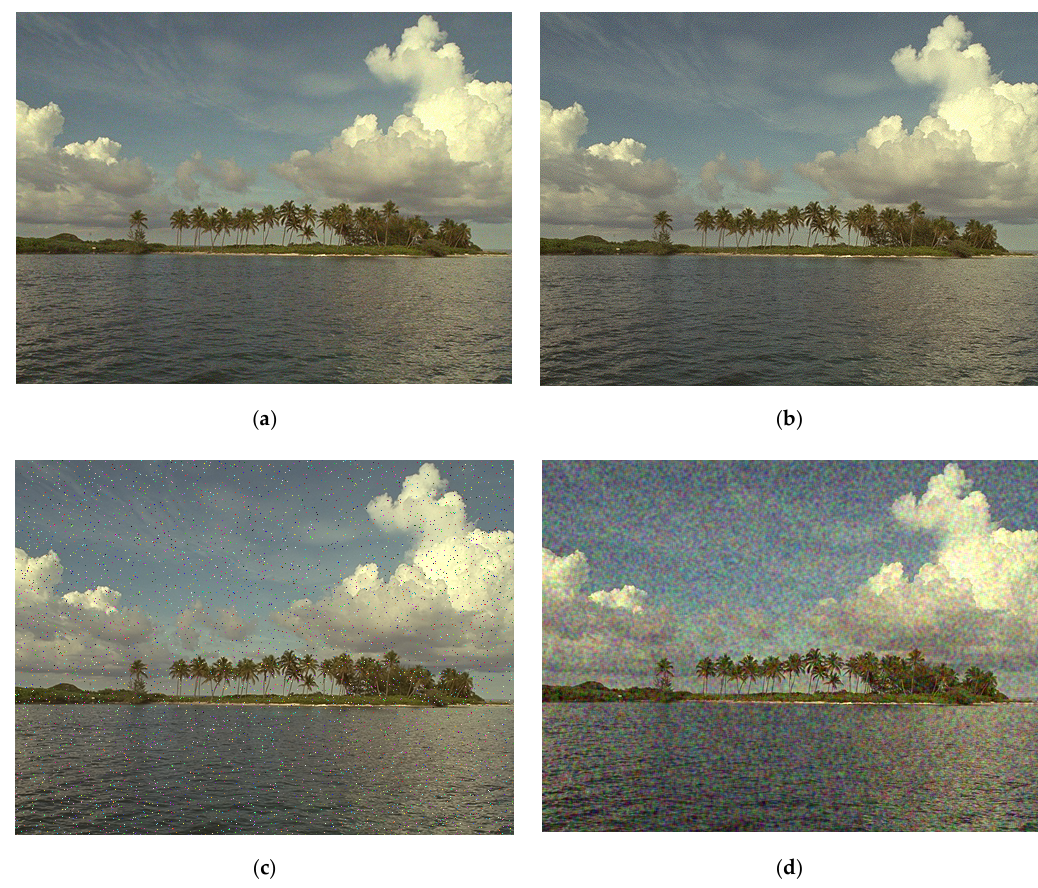
Figure 1. Examples of the test image with different quality: ( a ) excellent (distortion type #2—additive noise in color components)—mean opinion score (MOS) = 6.15, peak signal-to-noise ratio (PSNR) = 40.773 dB, PSNRHA = 36.935 dB, Mean Deviation Similarity Index (MDSI) = 0.19; ( b ) good (distortion